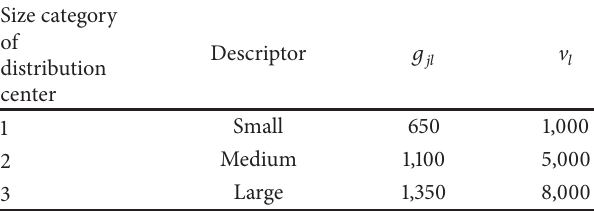
Table 1: Parameters related to different distribution centers.